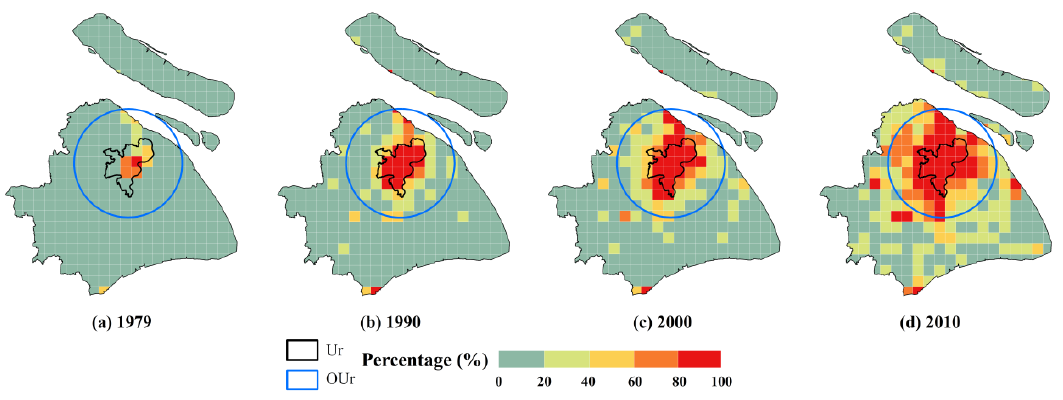
Figure 8. The percentage of the built-up areas in: ( a ) 1979; ( b ) 1990; ( c ) 2000; and ( d ) 2010.